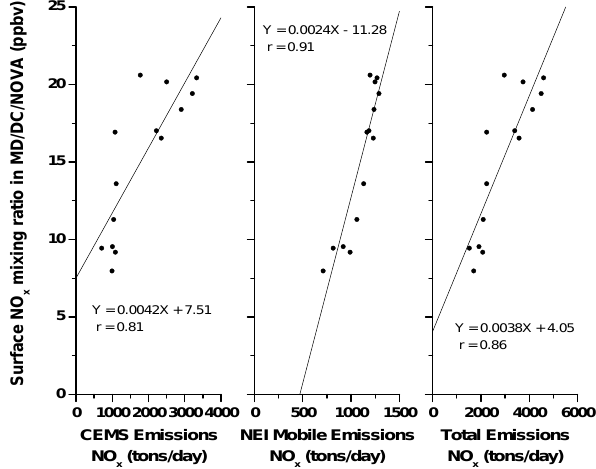
Fig. 6. Linear regression analysis of the long-term CEMS, NEI, and (CEMS + NEI) NO x emissions with EPA AQS observations; left: CEMS emissions only; middle: NEI mobile emissions (inter- polated from triennial inventories to annual estimates) only; right: total emissions (CEMS emissions + NEI mobile